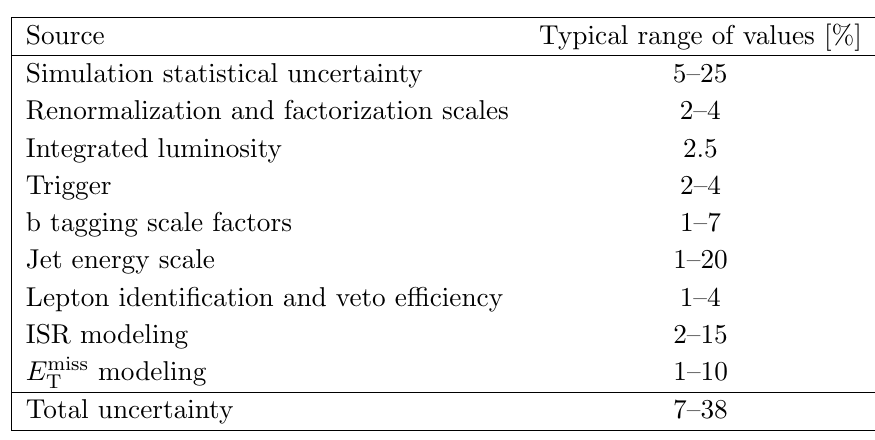
Table 6 . Summary of the systematic uncertainties in the signal e(cid:14)ciency.